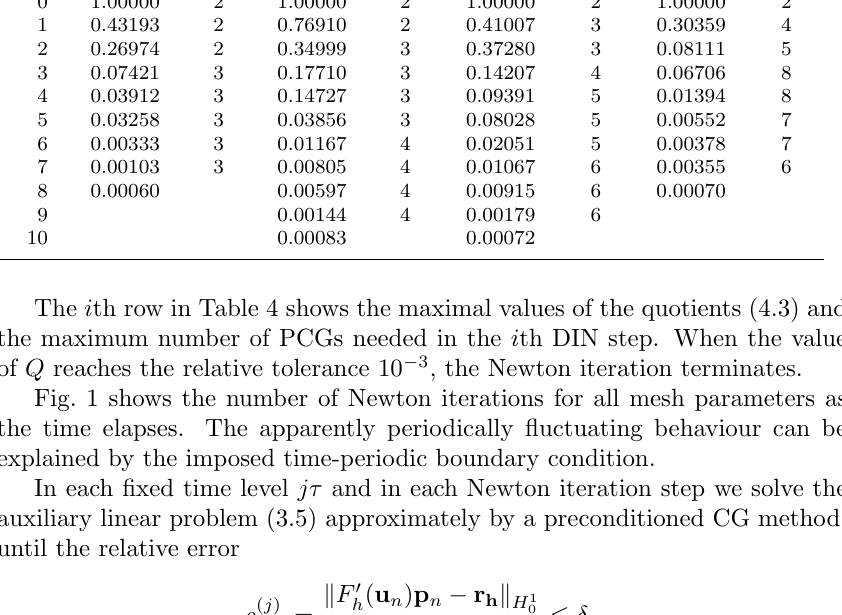
Table 4. The maximal relative errors and the number of PCGs. N = 4 N = 8 N = 16 N = 32